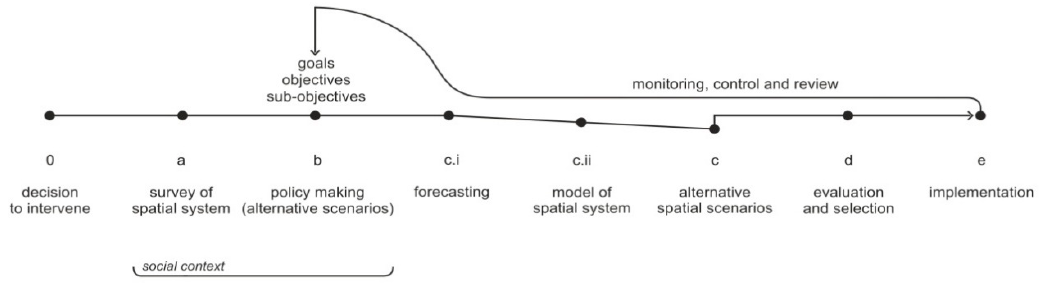
Figure 1. The components of the comprehensive land-use planning model, according to McLoughlin [8], in a diagrammatic form. Dark circles: the model’s components presented on a methodological axis. Below the axis: contextual factors.